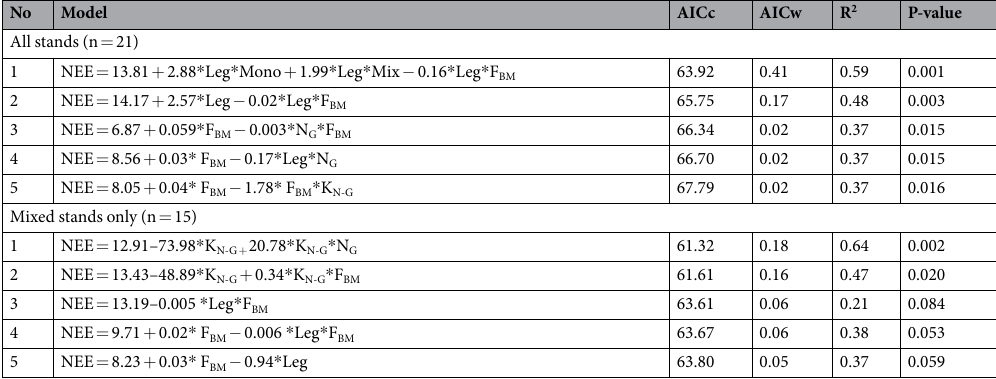
detected positive correlations between carbon and water fluxes and a functional diversity metric (Rao’s quadratic entropy of leaf N concentrations, FD Q -N), which captures the diversity/dissimilarity of foliar N concentrations between the species of a mixture. Here, we directly tested the hypothesis that that FD Q -N could be a good proxy of K N and found no supporting evidence that FD Q -N is positively correlated with K N-F and K N-G . However, one caveat needs to be noted relative to the previous studies proposing FD Q -N as a good proxy of K N . In this study, the calculation of FD Q -N was based on values of foliar N measured in plants collected in situ but not directly from the plots included in our experiment. Although the literature is abundant with functional trait-based metrics cal- culated with literature-derived or non in-situ measured trait values 39–41 , the fact that FD Q -N was calculated with